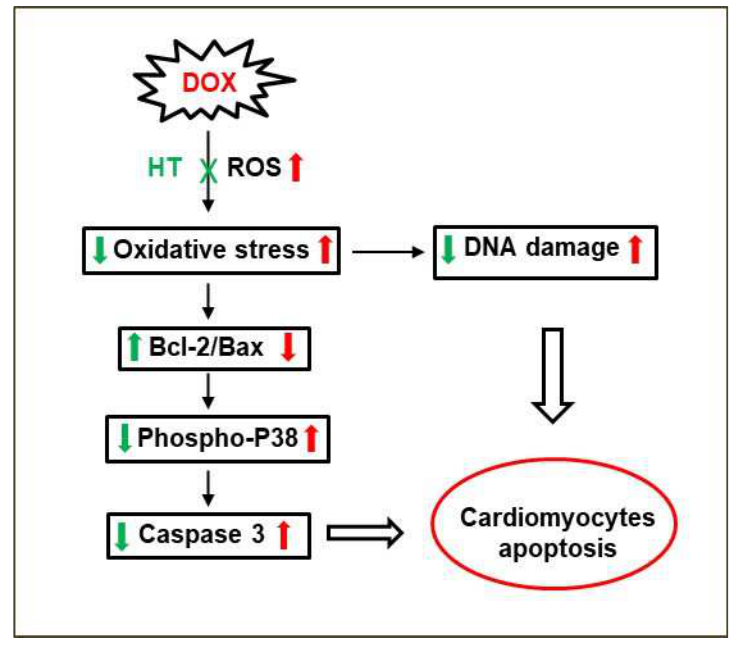
Figure 9. Working hypothesis on the role of HT in Dox-induced cardiotoxicity.